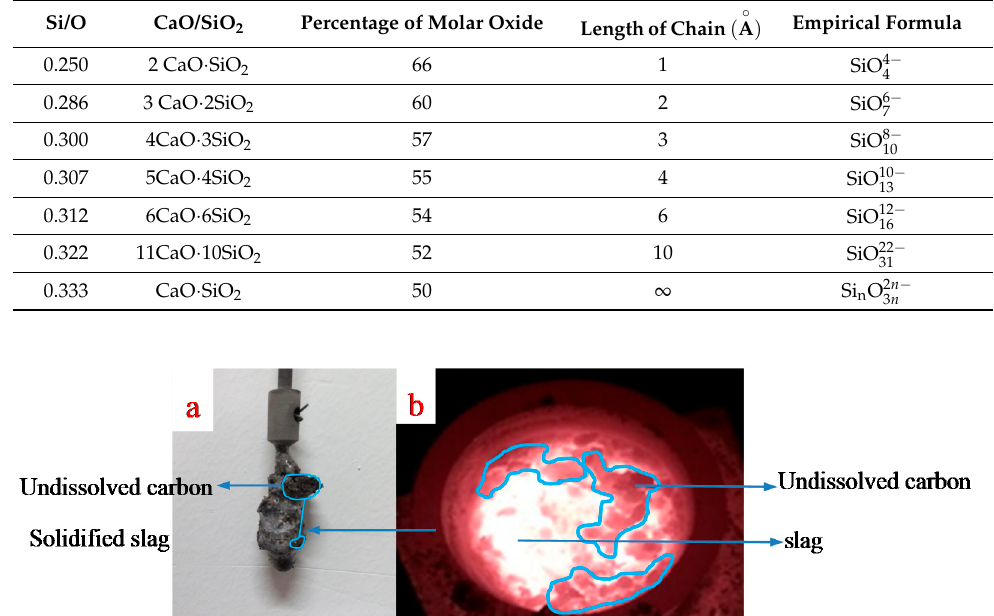
Table 4. Empirical formulas of the anions in the range of Si/O = 0.25–0.33 (66–50% MO).